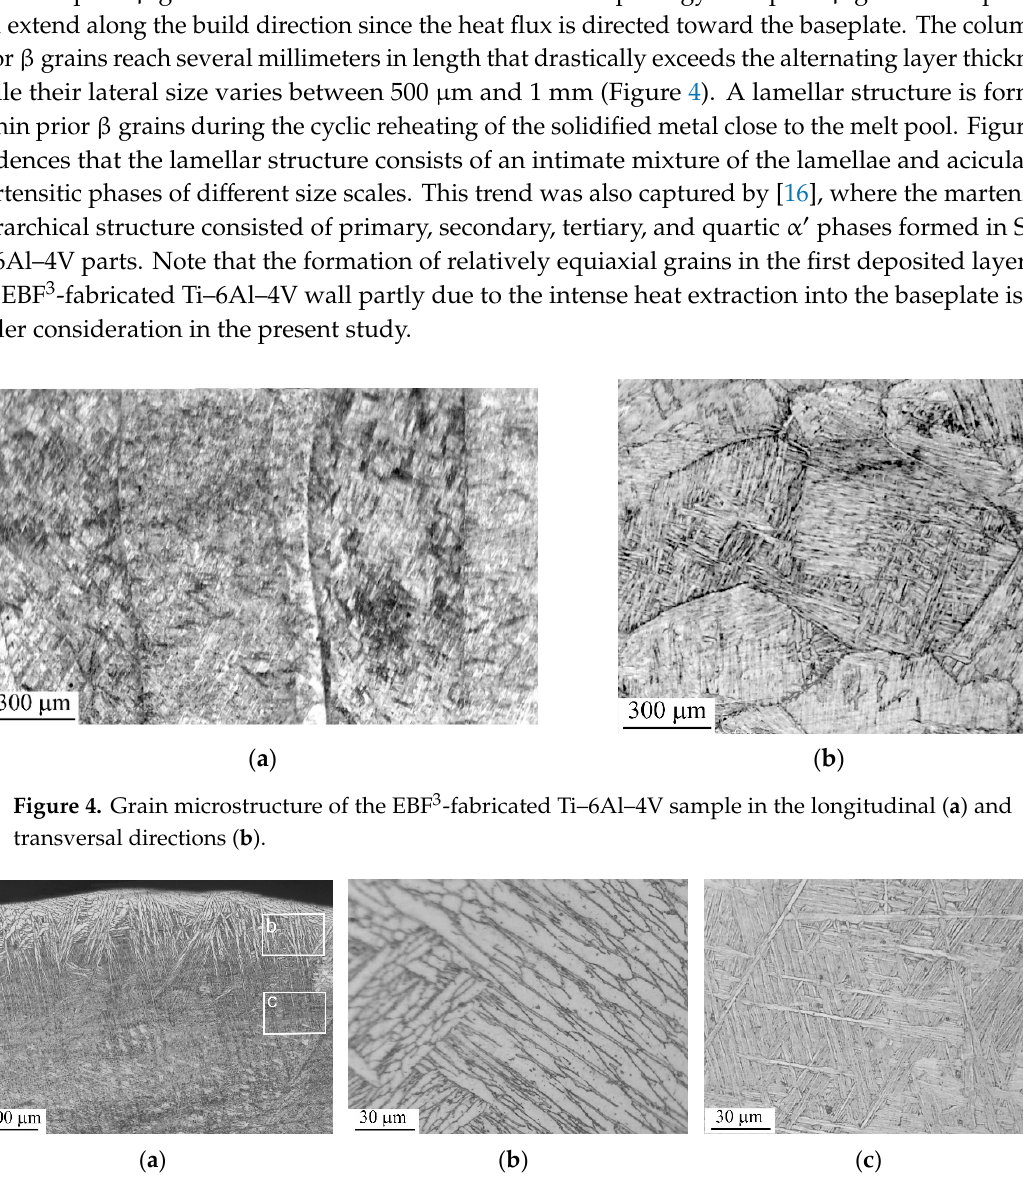
( e ) Figure 6. TEM bright- ( a ) and dark-field images ( b – d ) and associated selected area electron diffraction (SAED) pattern ( e ) of the microstructures within the outermost surface layer of the EBF 3 -fabricated Ti–6Al–4V sample. b—the dark-field TEM image obtained with the 00 2 α -Ti and 110 β -Ti reflections (marked by an arrow 1 in ( e )), c—dark-field TEM image obtained with the 10 2 α -Ti and 200 β -Ti reflections (marked by an arrow 2 in ( e )), d—dark-field TEM image obtained with the 1 10 β -Ti and 002 α′′ -Ti reflections (marked by an arrow 3 in ( e )).